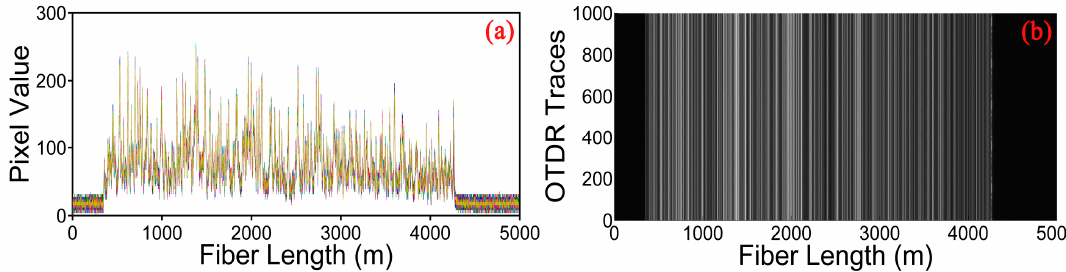
Figure 2. ( a ) Location information constituted by consecutive raw Rayleigh backscattering curves for 50 Hz vibration event; ( b ) A gray image constituted by consecutive Rayleigh curves.